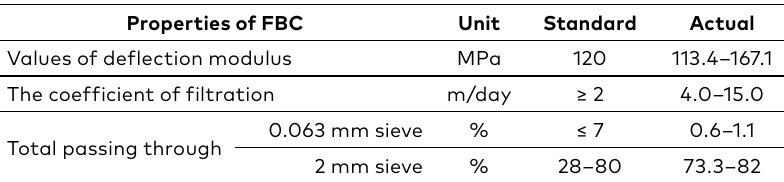
Table 1. The comparison of standard and actual